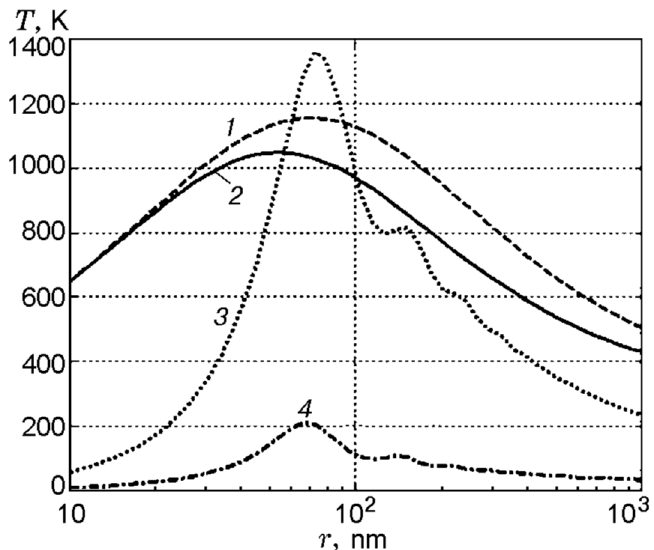
Figure 20. Maximum heating temperature of metal nanoparticles in an inert matrix having thermophysical properties of PbN 6 (laser pulse length 30 ns and energy density of 50 mJ / cm 2 ): curve 1 stands for Ag ( η = 1) and curve 2 to Pb ( η = 1); curves 3 and 4 refer to Ag and Pb with account of the dependency η ( r ). Reproduced from [61], with permission from Combust., Explos., Shock Waves, 2012.